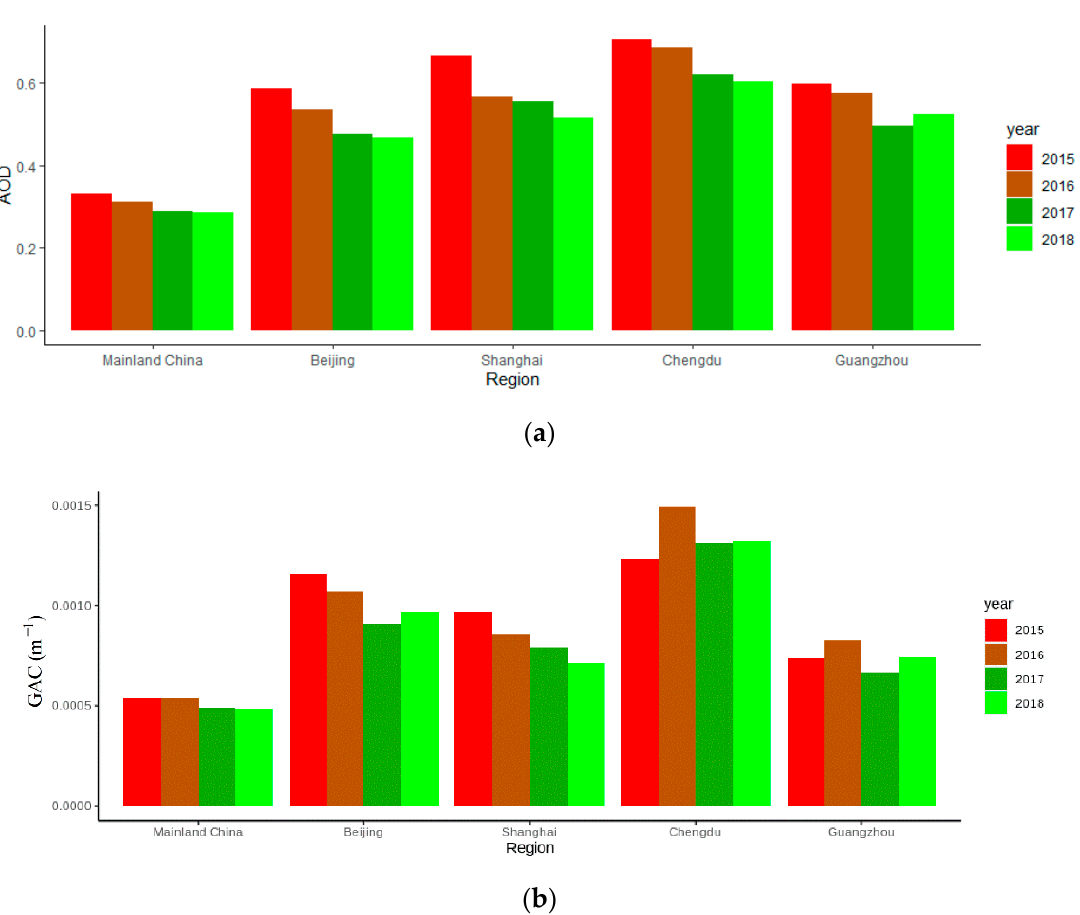
Figure 13. Average annual AOD ( a ) and ground aerosol coefficient ( b ) in mainland China and four megacities from 2015 to 2018.